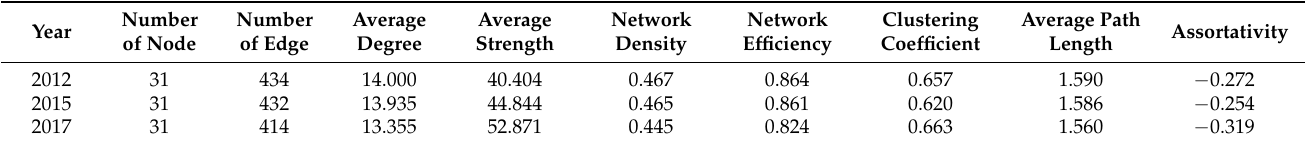
Table 2. Calculation results for structural characteristic indicators of ECETN.